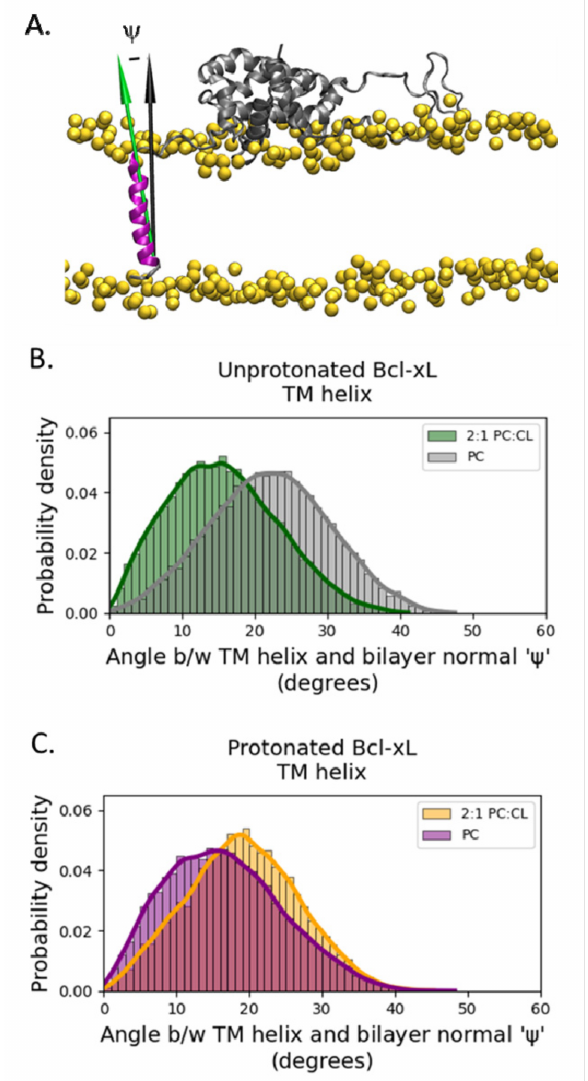
Figure 6. Orientation of the transmembrane (TM) helix. ( A ) The orientation of helix α 8 was deter- mined by the deviation angle, ψ , of the helix principal axis (green arrow) from the membrane normal (black arrow). The protein is shown in secondary structure representation colored gray, except for helix α 8 which is shown in purple. The lipid phosphate phosphorus atoms are shown as yellow spheres. The rest of the simulation system has been removed for clarity. Distributions of TM helix angles for unprotonated ( B ) and protonated ( C ) simulations show significant overlap and provide no information correlated with soluble head